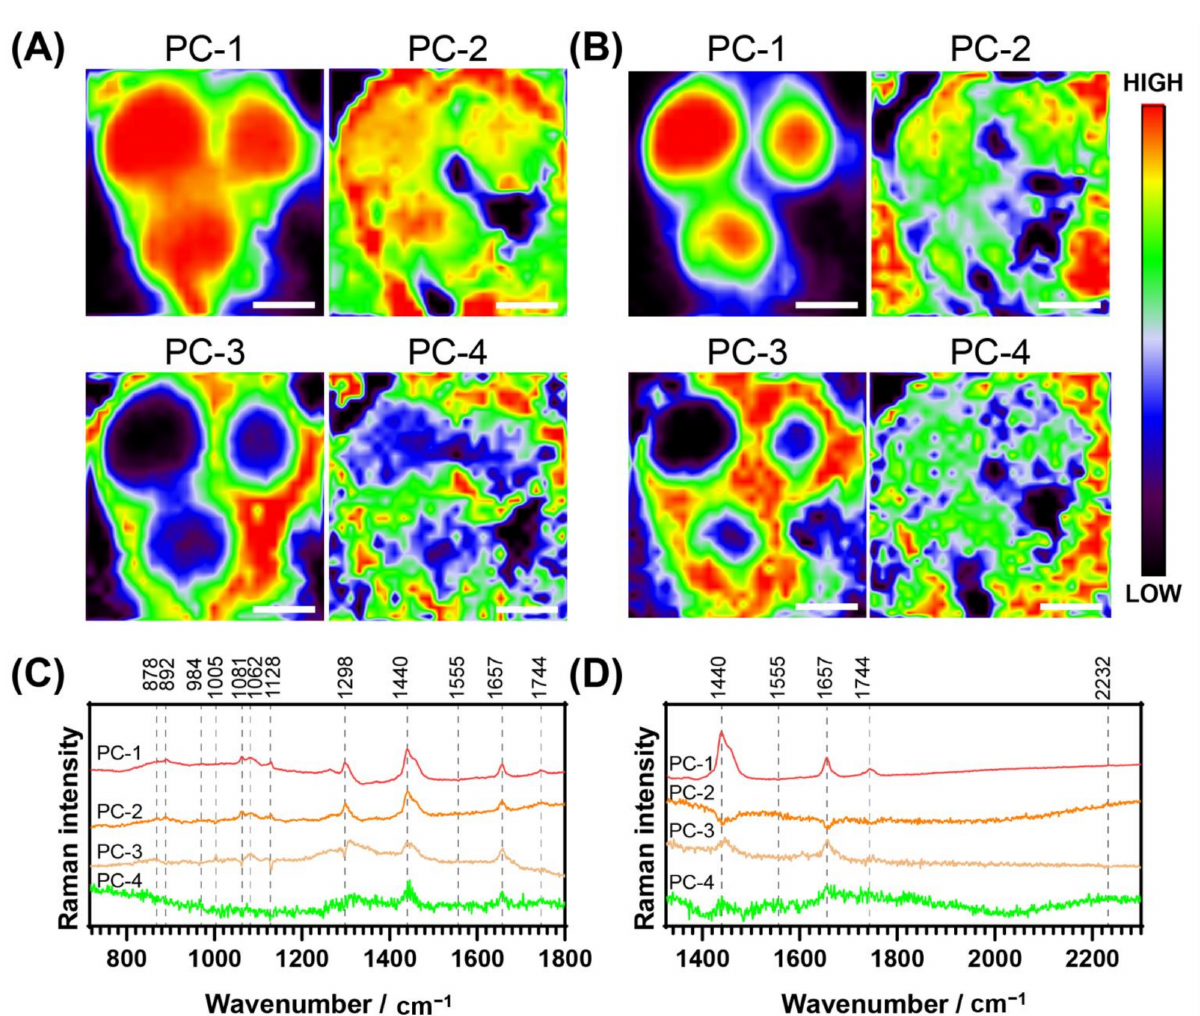
Figure 5. Principal component analysis of the Raman spectra of a cell dosed with NpCN1 (20 µ M, 4 h); same representative cell as shown in Figure 4. ( A , B ) show the PC maps of each of the scores of the four main PC of the spectra collected from 715–1806 cm − 1 and 1327–2304 cm − 1 , respectively. ( C , D ) show the loadings of the scores mapped in ( A , B ), respectively. The scale bar represents 10 µ m for all